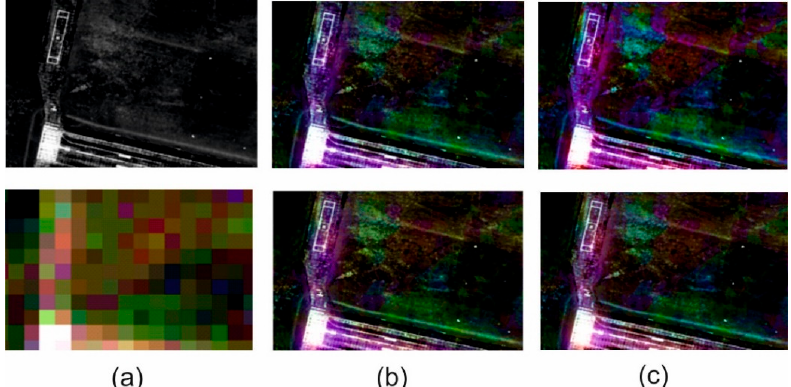
Figure 11. ( a ) Original panchromatic WorldView-2 image and multispectral Landsat 5 TM image. ( b ) Results of data fusion using the classical approach (above) and modified approach (below) after GIHS fusion. ( c ) Results of data fusion using the classical approach (above) and modified approach (below) after GIHS-BT fusion for open area.